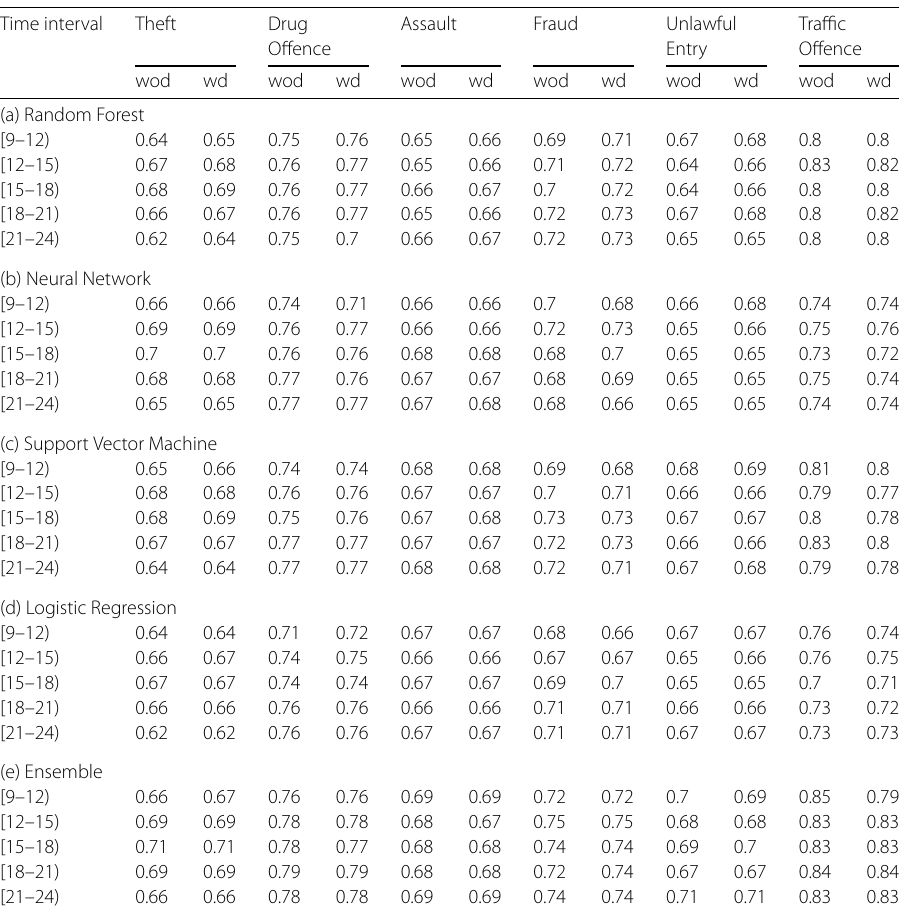
Table 6 AUC comparison with and without dynamic features for New York City. “wod” and “wd” represent without and with dynamic features, respectively Time interval Theft Drug Assault Fraud Unlawful Traffic Offence Entry